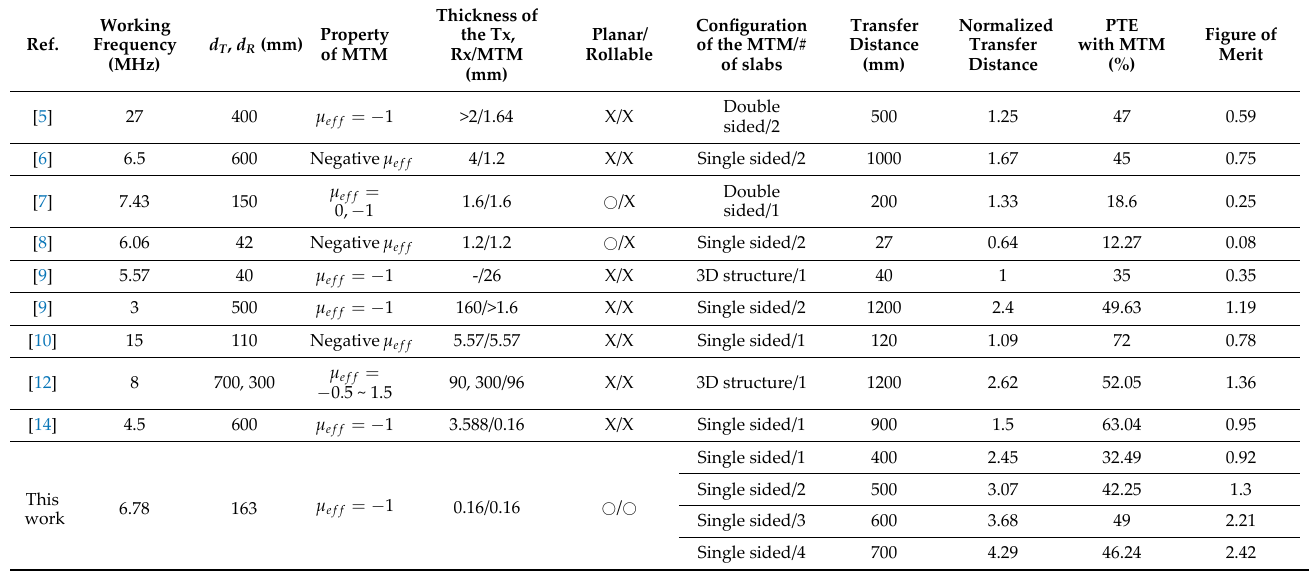
Table 2. Comparison of this work with other MTM‑ or MS‑based WPT